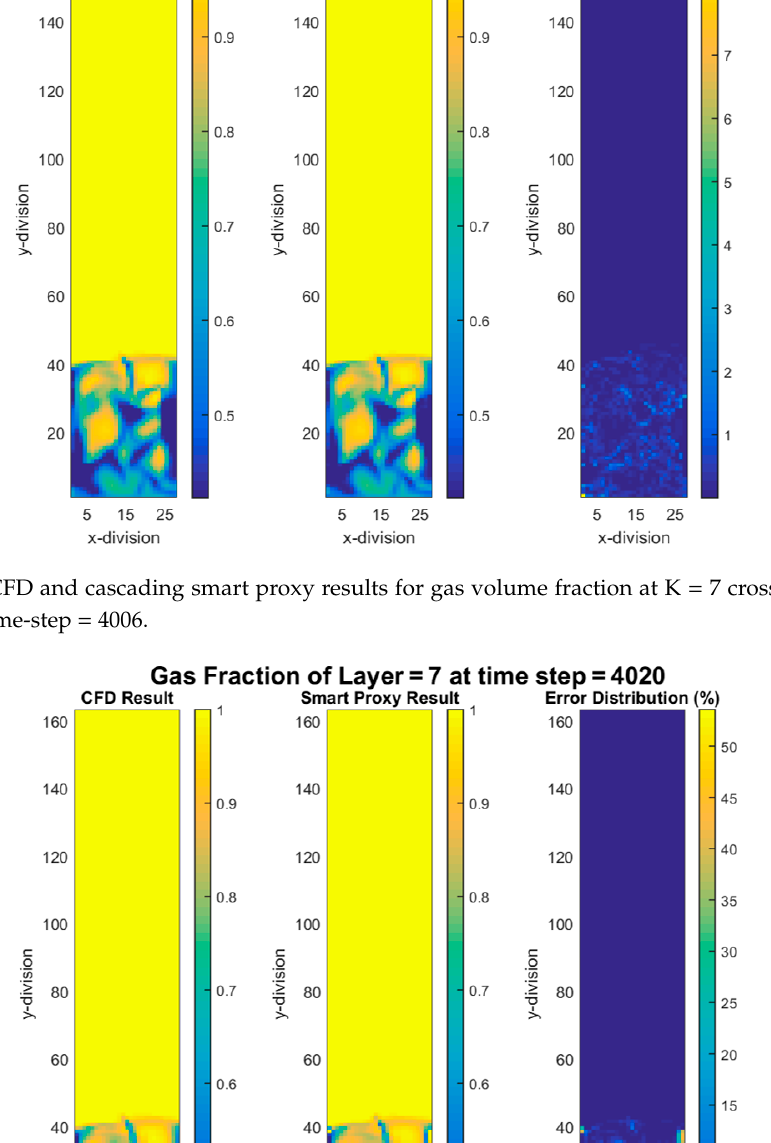
Figure 18. CFD and cascading smart proxy results for gas volume fraction at K = 7 cross-sectional plane and time-step = 4004.